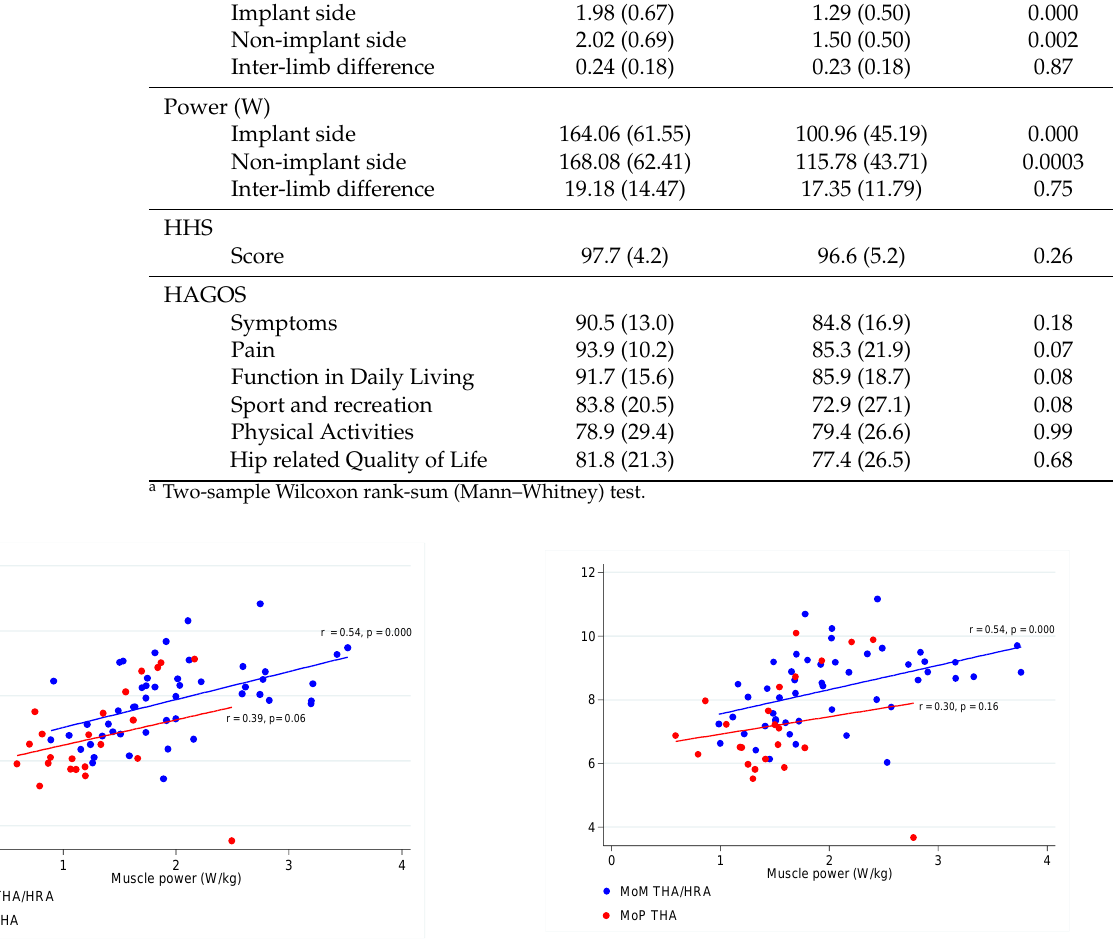
Table 4. Inter-limb difference in trunk Range of Motion in the sagittal and frontal plane measured from step test obtained in the MoM THA/HRA ( n = 45) and MoP THA ( n = 19) group, respectively. Values are mean (SD).